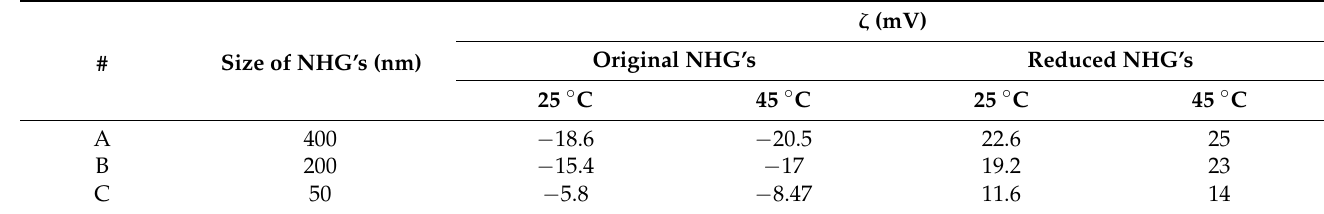
Table 2. Zeta potential value of NHG’s. Results are reported as mean ± S.D ( n = 3).